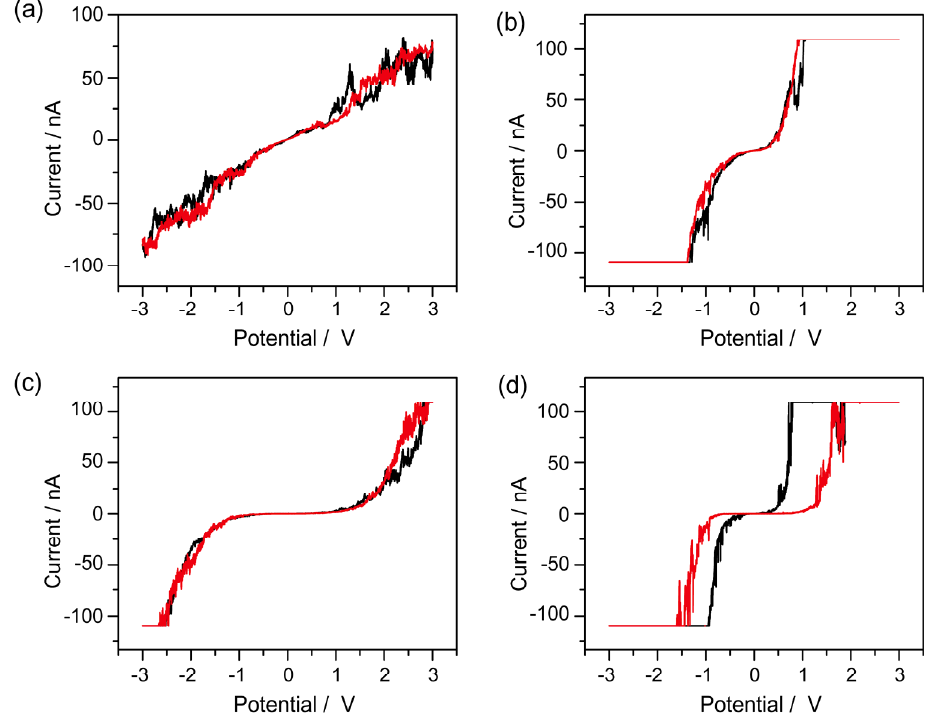
Figure 4. I–V characteristics obtained from scanning tunneling spectroscopy (STS) for ( a ) bare Au; ( b ) CdSe-ZnS on Au; ( c ) azurin on Au; and ( d ) azurin/CdSe-ZnS on an Au electrode respectively.